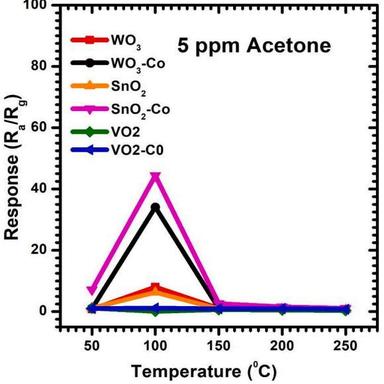
Gas response of WO3, WO3-Co, SnO2, SnO2-Co, VO2, and VO2-Co-based sensors versus operating temperatures to 5 ppm acetone concentration. (For interpretation of the references to colour in this figure legend, the reader is referred to the web version of this article.)